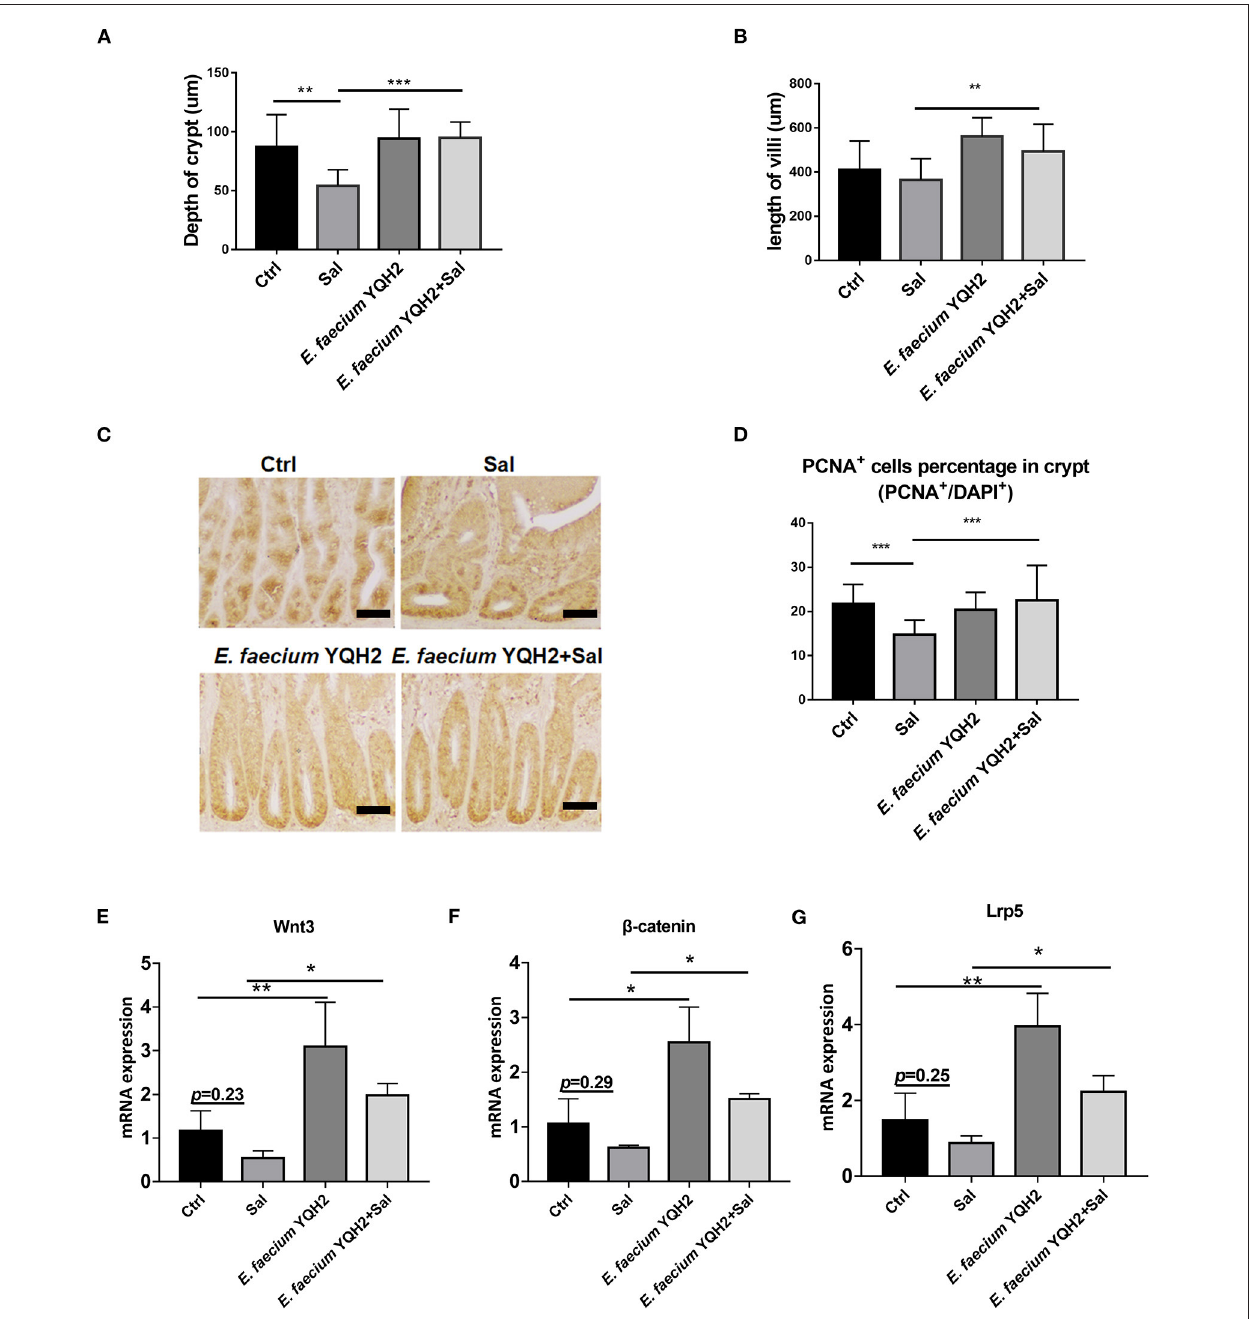
FIGURE 3 | Enterococcus faecium YQH2 increased Wnt expression to promote steam cell proliferation. (A,B) The height of jejunum villus and the depth of crypt were measured in different groups, n = 50 (scale bars = 50 µ m). (C,D) Immunohistochemistry staining of PCNA in ileums of chicken. The number of PCNA-positive cells in at least 50 crypts was detected (scale bars = 50 µ m). (E–G) The expression of proliferating genes in intestinal stem cells in the ileum, including Wnt3, β -catenin, and Lrp5, was detected by real-time fluorescence quantitative PCR, n = 8. * p < 0.05, ** p < 0.01, *** p < 0.001.